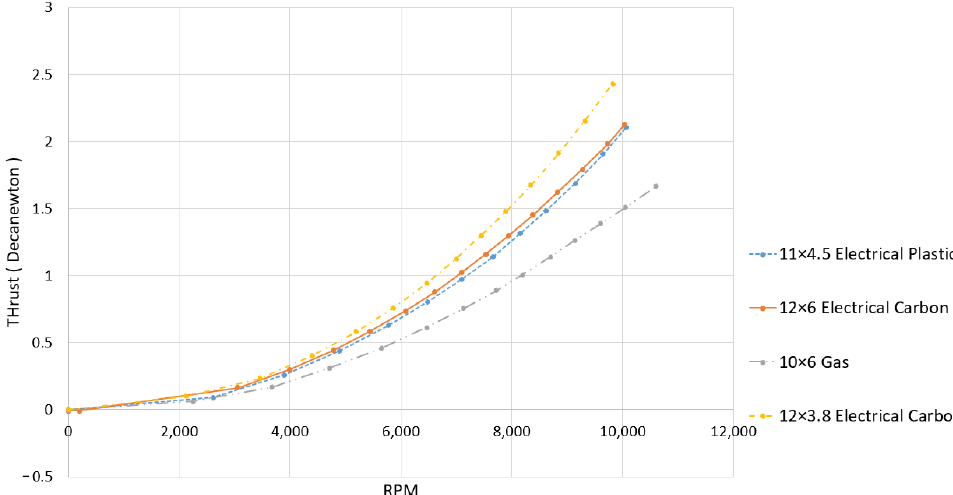
Figure 4. Thrust output of various propellers for the range of engine RPM